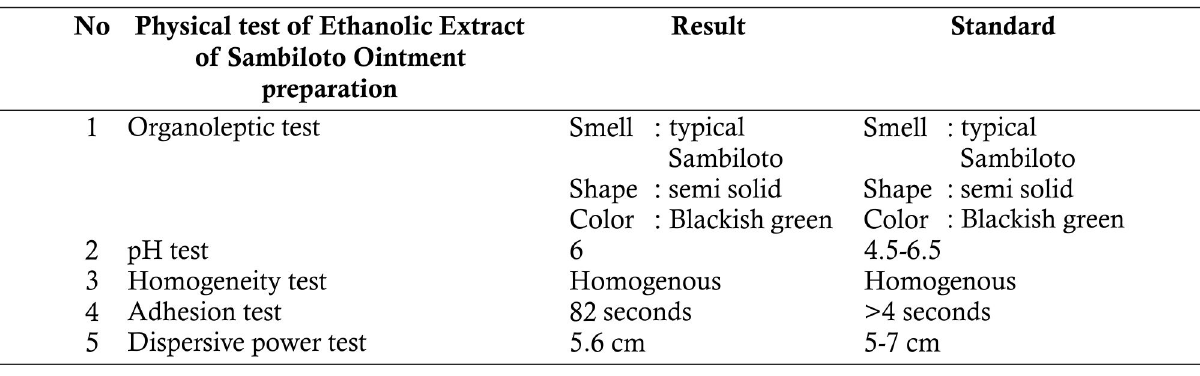
in this study consisted of organoleptic test, pH test, homogeneity test, adhesion test and dispersive power Results of Physical test of Ethanolic Extract of Sambiloto Ointment